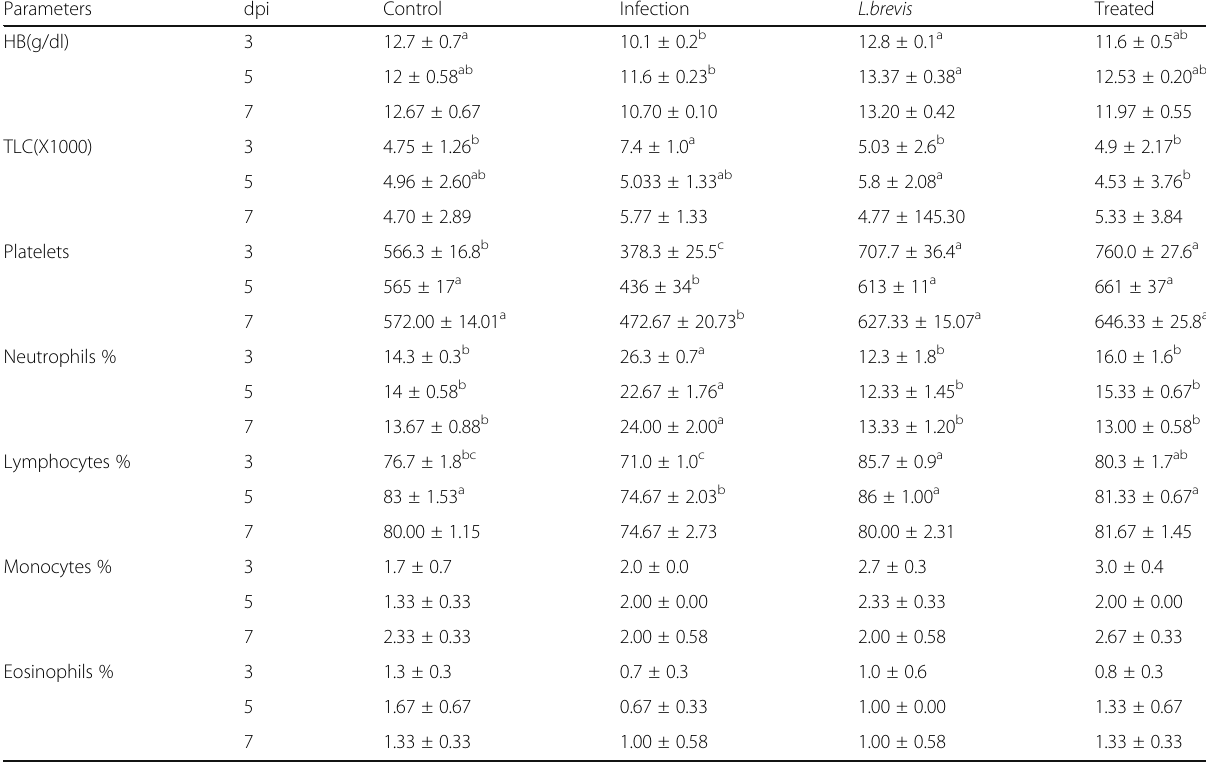
Table 3 Effect of L.brevis on the course of listeria infection: changes in hematological parameters